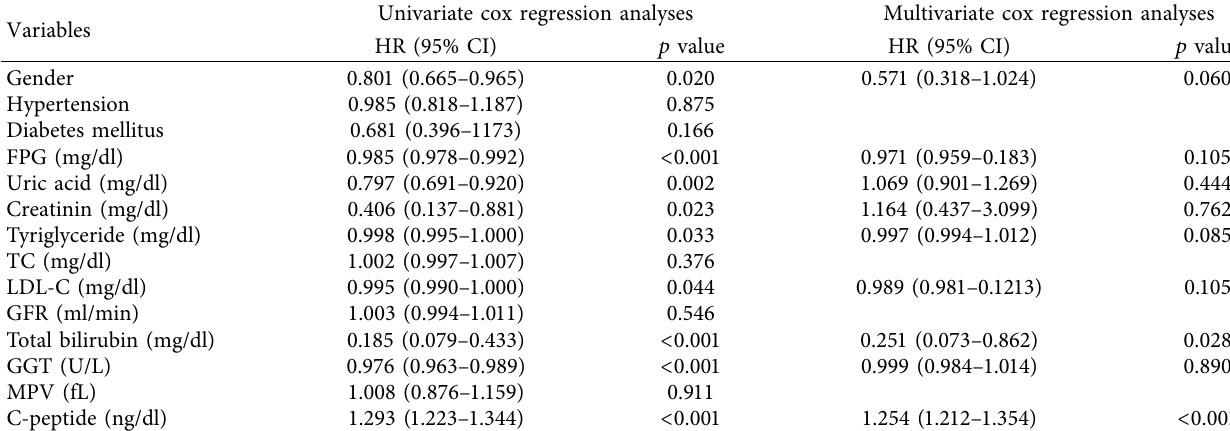
Table 7: Univariate and multivariate cox regression analysis to evaluate the association between DM and MACE in patients with